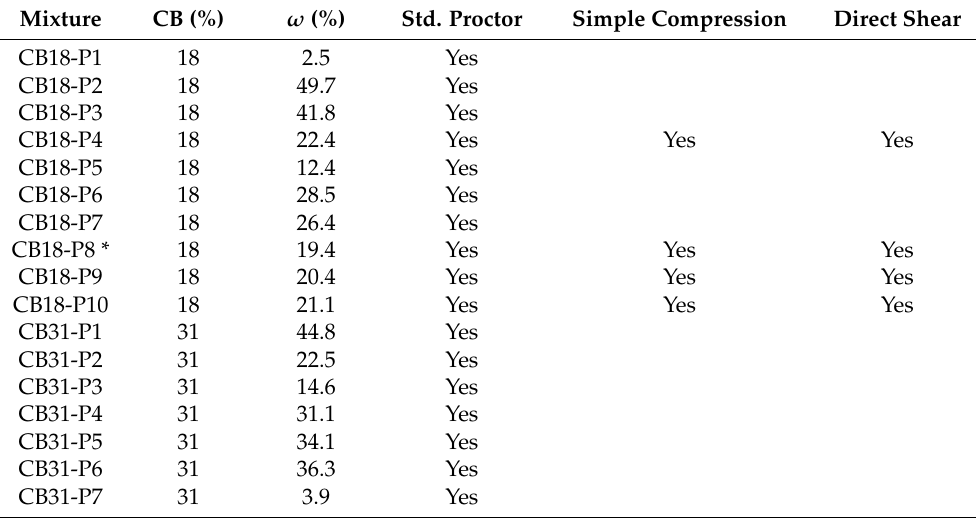
Table 3. Summary of the geotechnical laboratory tests performed on each mixture.